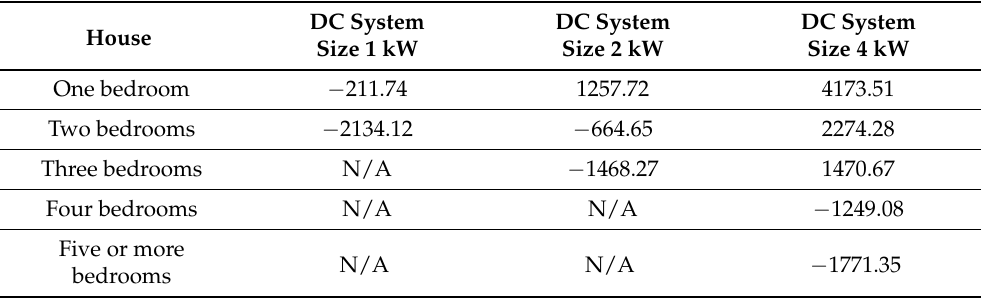
Table 5. Differences in demand profiles vs. PV power